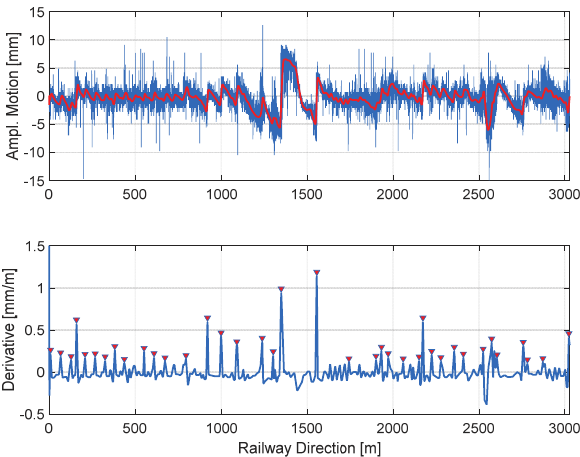
Figure 14. (a) Original estimates of the amplitude of seasonal deformation in blue, and the denoised deformation estimates in red estimated by regularizing on the total variation of its second order derivative, and (b) peaks detected in the derivative of the denoised deformation function along the railway direction. They are the locations of the railway segment joints.